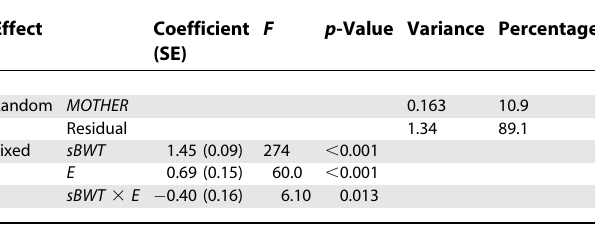
Table 3. Mixed-Model Analysis of Offspring Fitness